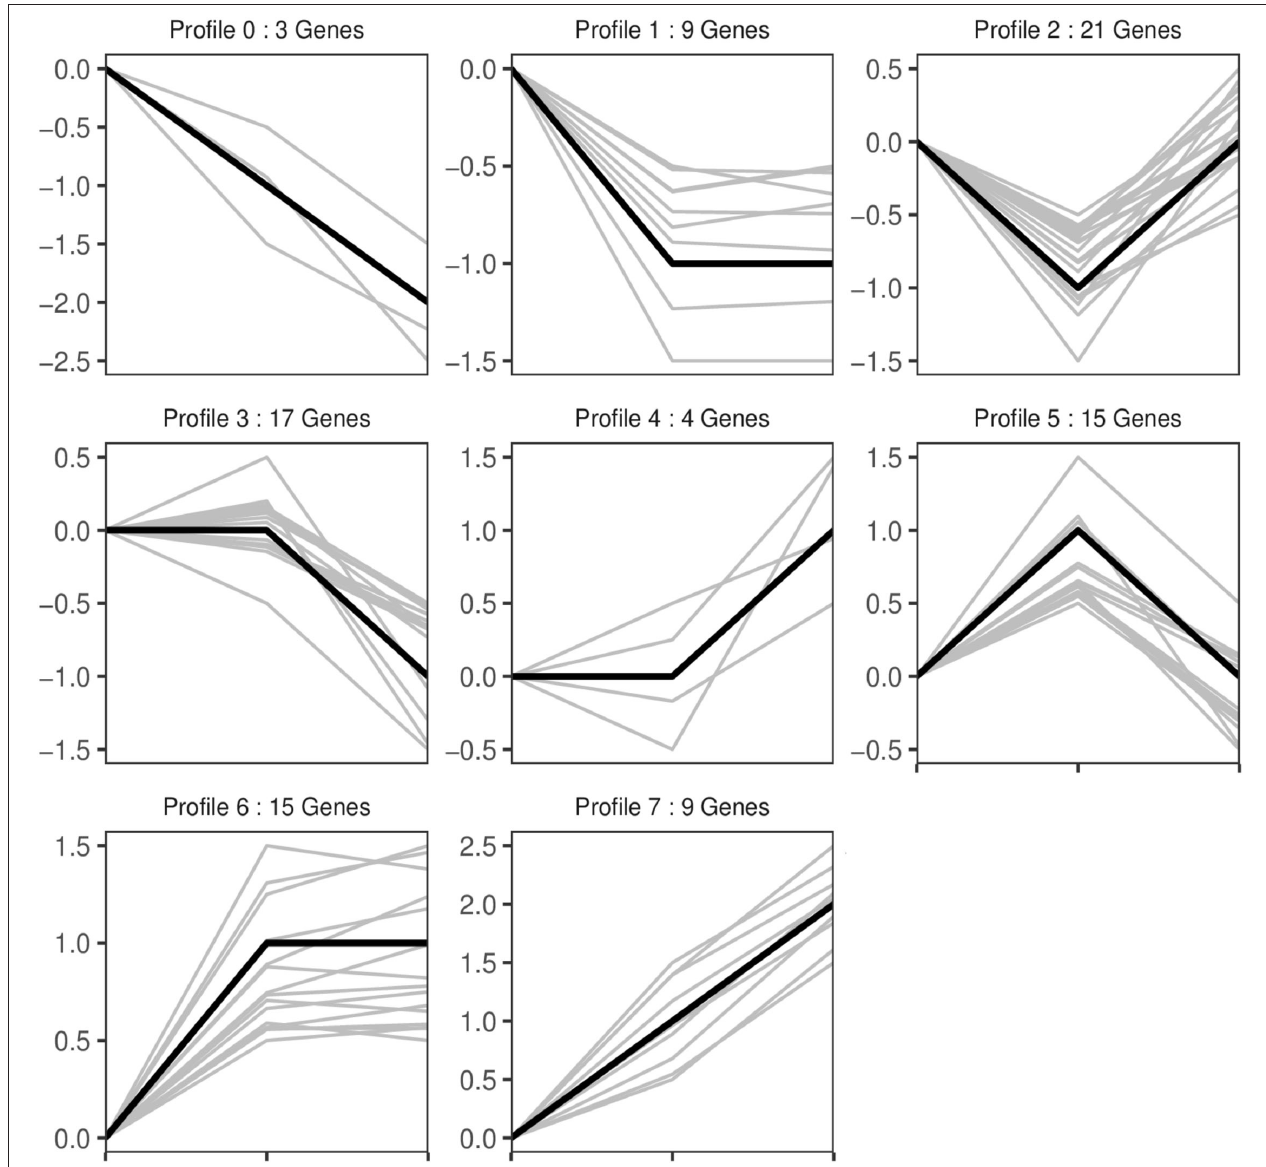
FIGURE 4 | The expression patterns of DEGs were analyzed. Each node in the profile is Control, BHBA-1.2 m M, and 2.4 m M from left to right